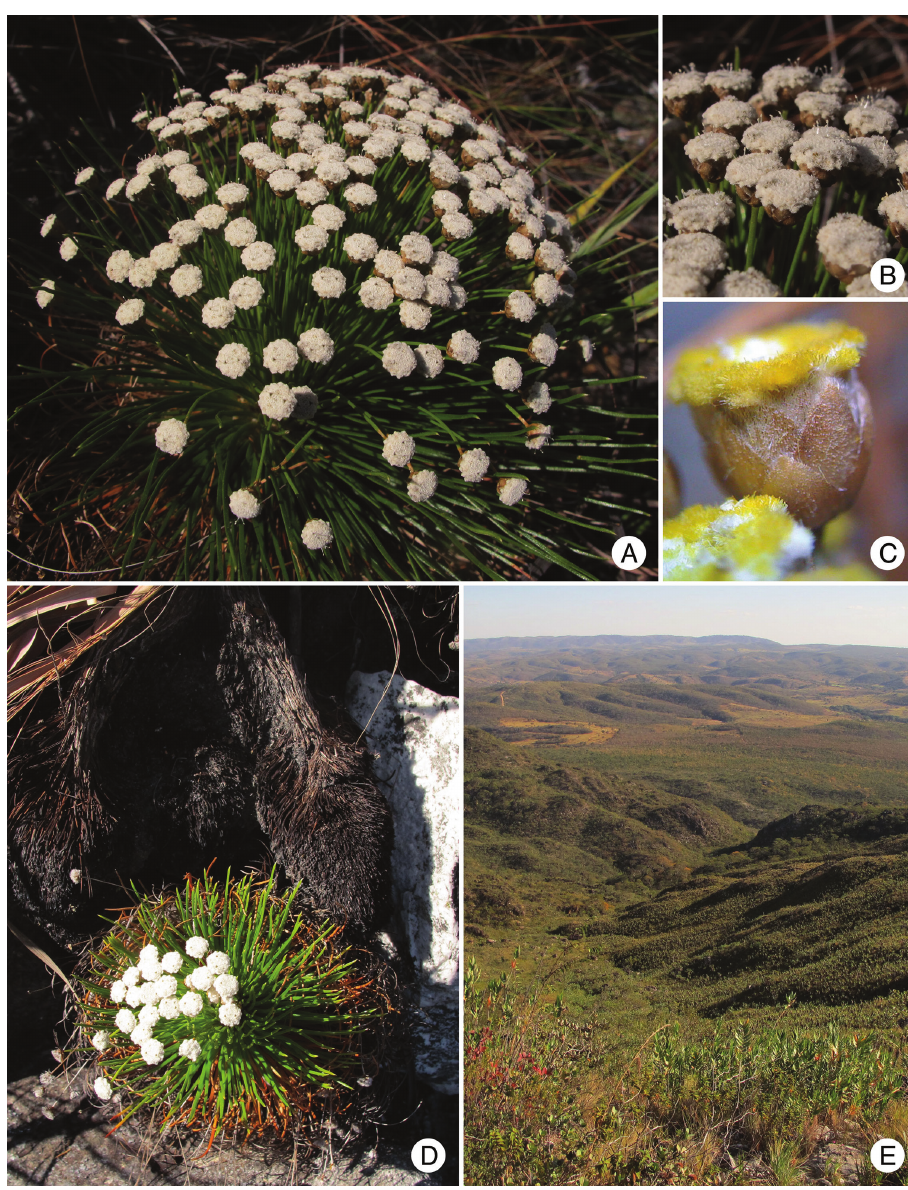
Figure 2. Paepalanthus serpens Echtern. & Trovó: A Habit B Capitula C Capitulum with yellowish hairs in a dried individual D Habit showing the elongate, thick and creeping stem, with erect apex E Habitat (Photos by L.